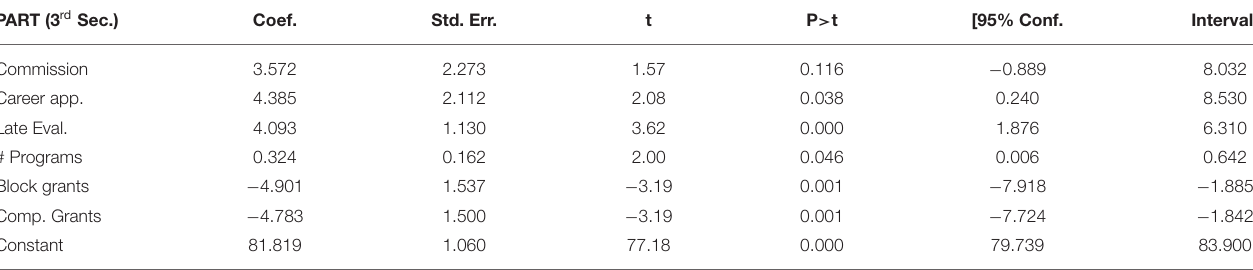
TABLE 8C | Model for program management section of PART. PART (3 rd Sec.)